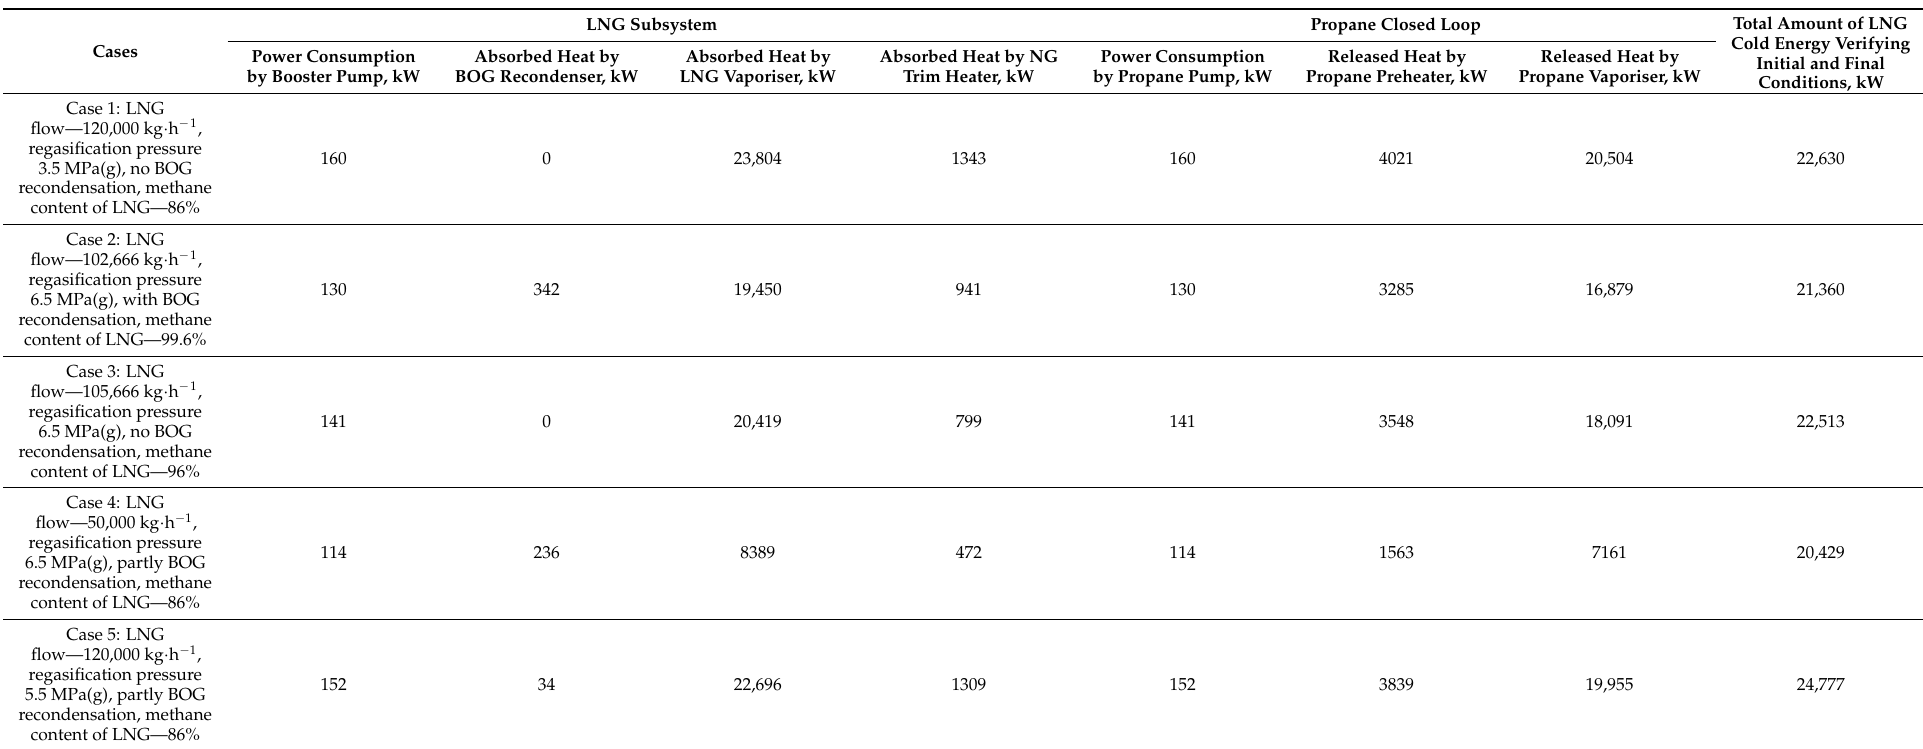
Table 5. Energy demand of the analysed LNG regasification cases at